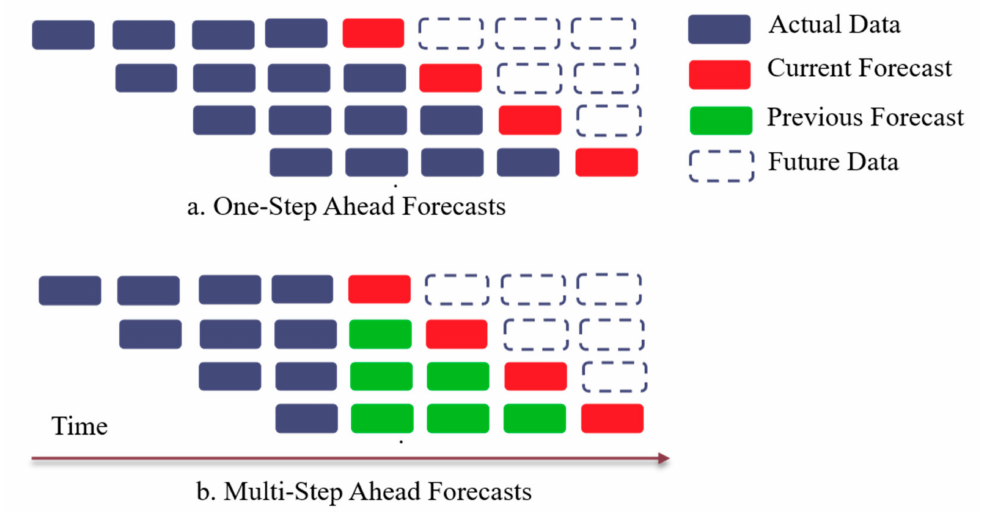
Figure 1. ( a ) One-step ahead forecasting where at each step forecast horizon = 1 and window size = w ( b ) Multi-step Ahead Forecasting where at each step forecast horizon = h , window size = w and the window of predictor variables is saturated with forecasted values after w iterations.